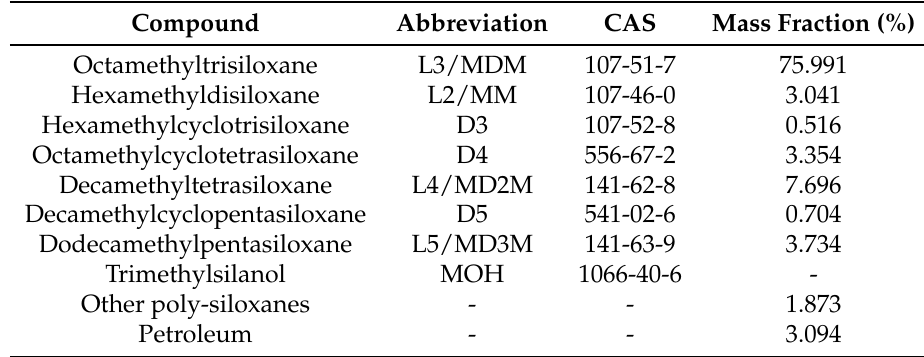
Table A2. HS-GC-MS analysis results of Experiment A, educt.